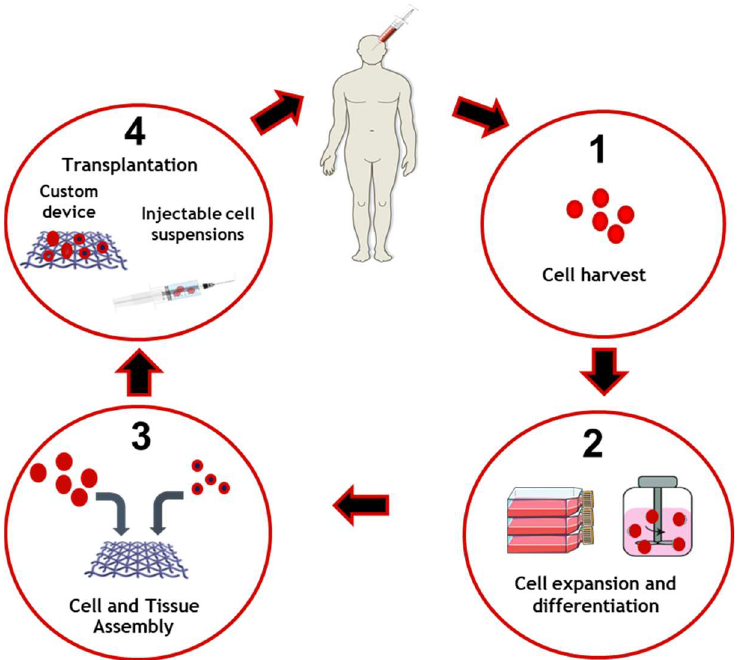
Figure 2. Tissue engineering applied to cell and tissue manufacture and delivery. Cells are collected and harvested in order to perform expansion and differentiation. Cells and bioengineered scaffolds are then assembled to be able to be transplanted on the patient.